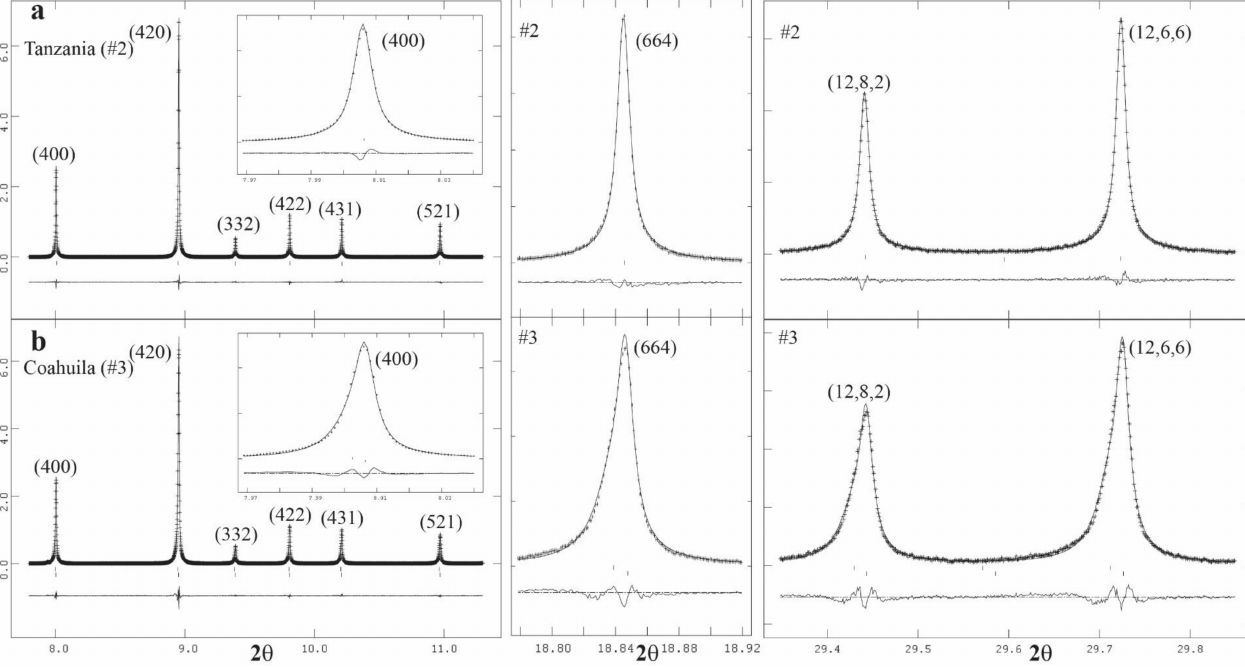
Figure 16. The same reflections are displayed for samples from ( a ) Tanzania (sample-2) and ( b ) Coahuilla, Mexico (sample-3). Each reflection peak in ( b ) is clearly asymmetric because of two different cubic phases, whereas those for the single cubic phase in ( a ) are sharp, narrow, and